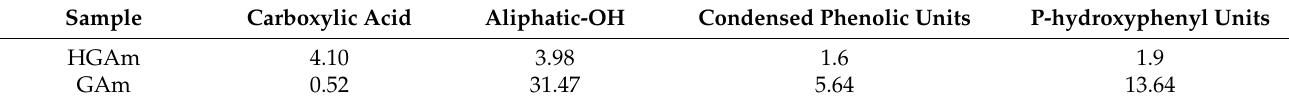
Table 1. Functional groups distribution (mmol/g) in HGAm and GAm polymers a